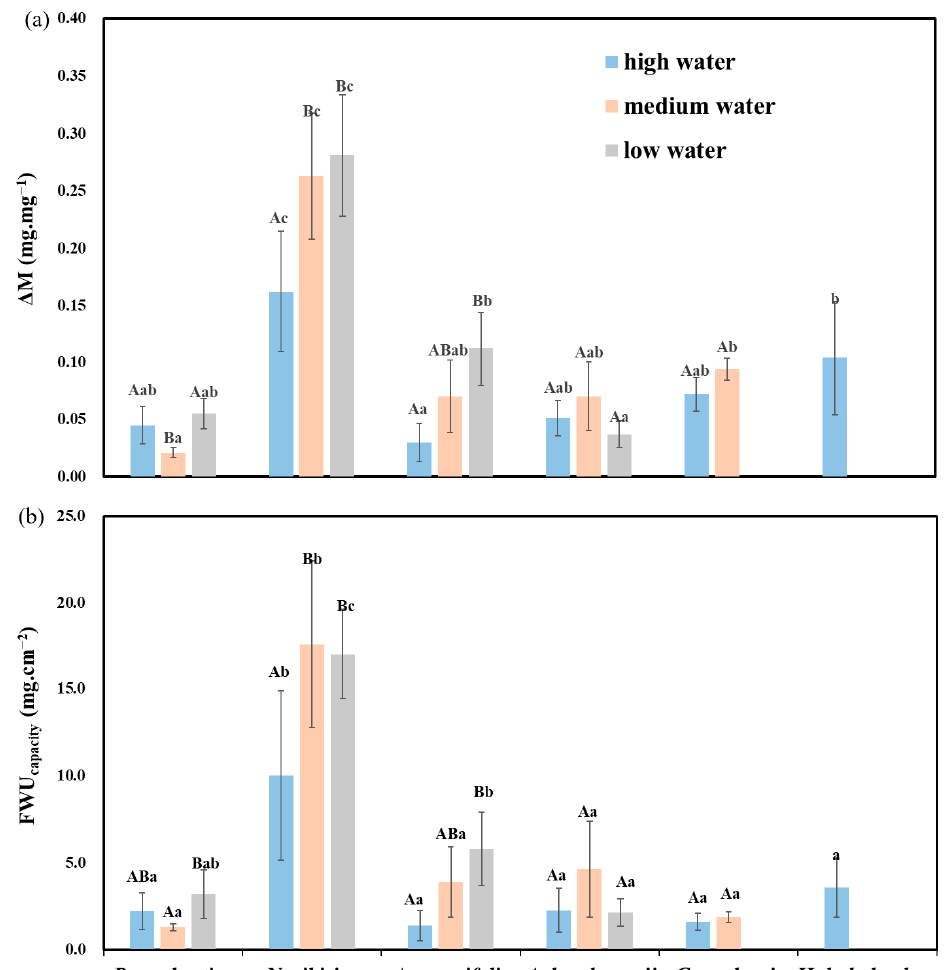
Figure 5. Differences in FWU parameters ( ∆ M and FWU capacity ) among water gradients and species. ( a ) The difference in foliar water uptake accumulation ( ∆ M) between species and water gradients; ( b ) FWU capacity among species and water gradients. Different lowercase letters indicate significant differences between species, and different uppercase letters indicate significant differences between water gradients (mean + SE; N = 4), α = 0.05.